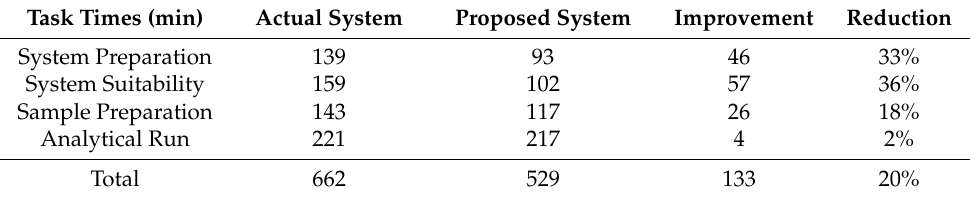
Table 2. Average task processing times